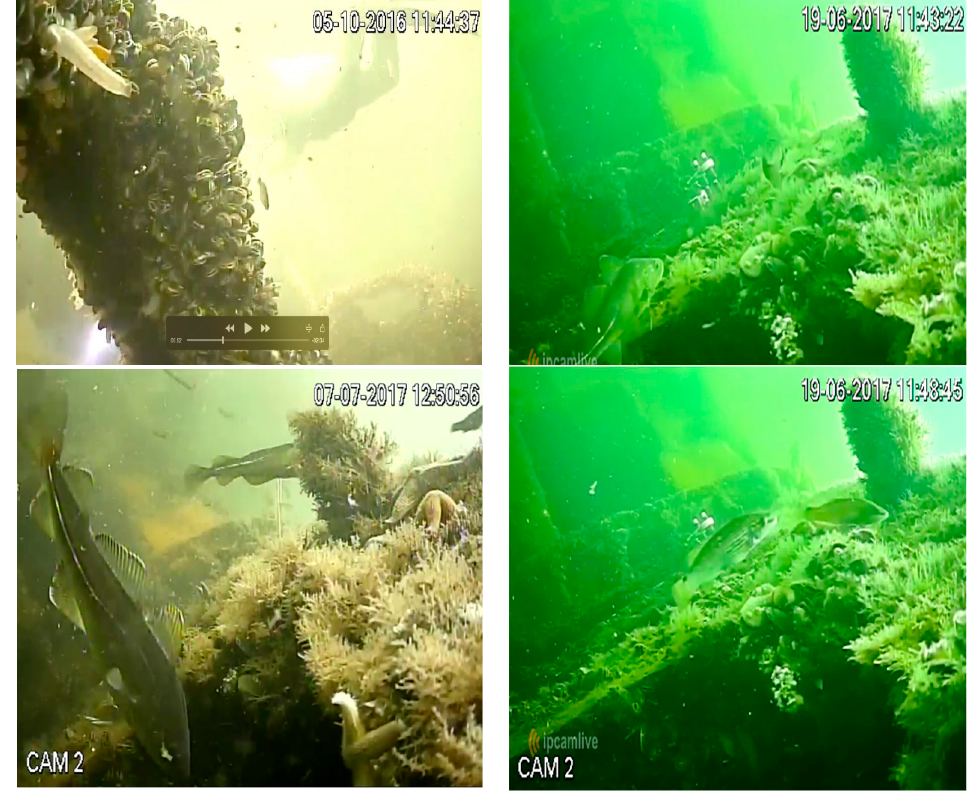
Figure 7. Screen shots from the live-stream taken between May 2016 and July 2017.